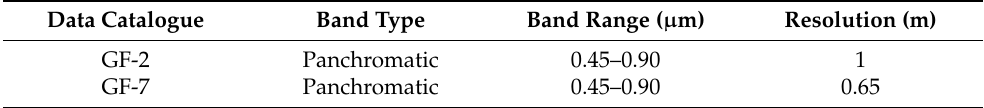
Table 1. Remote sensing image information used in the